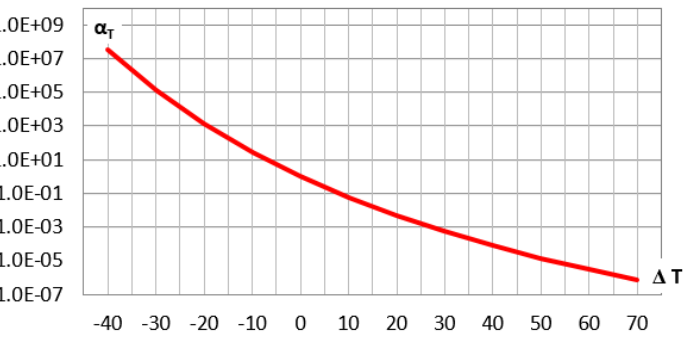
Figure 17. The shift factor α T diagram as a function of temperature increment (cid:52) T i = T i − T 0 .